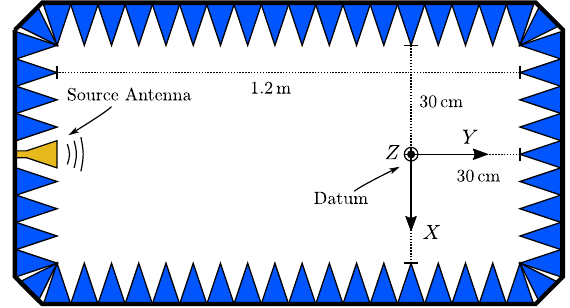
Figure 7. Chamber design schematic cross